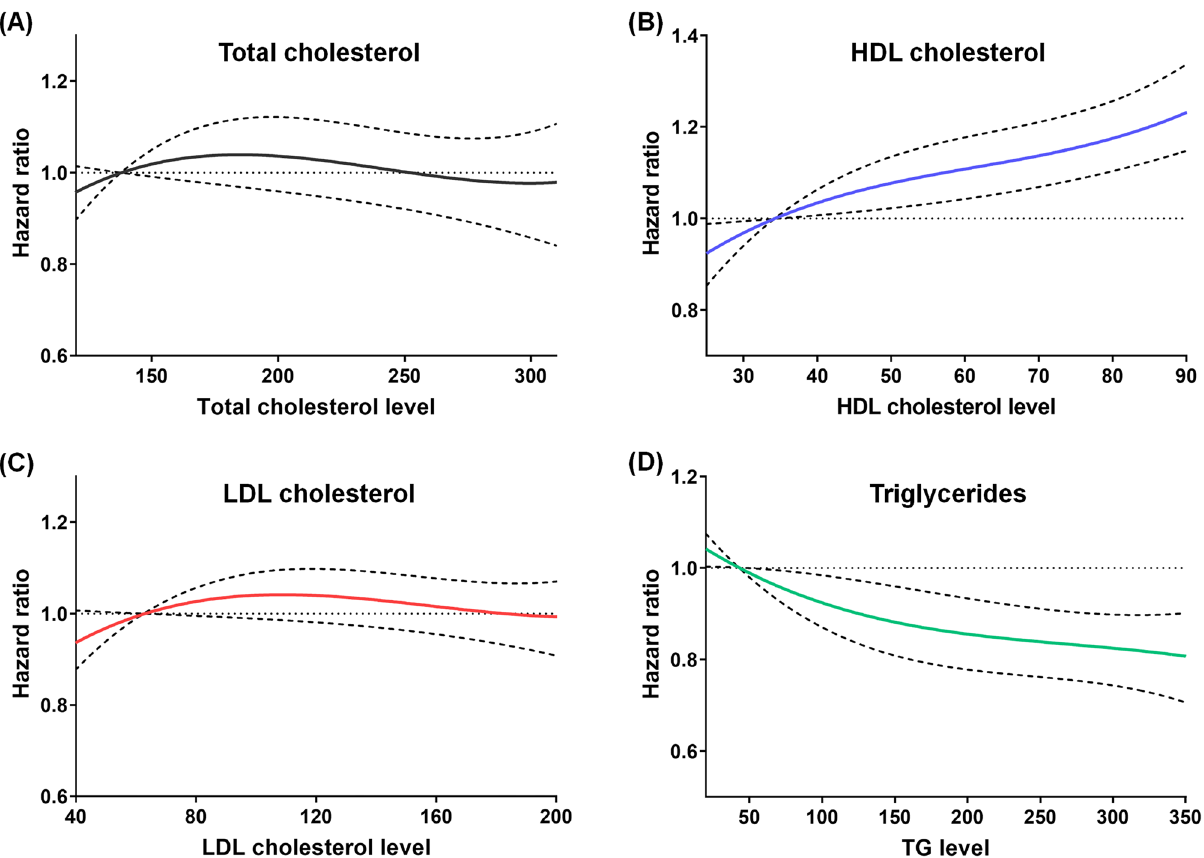
Figure 2. Restricted cubic spline curves presenting the adjusted hazard ratio for exudative age-related macular degeneration incidence according to total cholesterol, high-density lipoprotein cholesterol, low-density lipoprotein cholesterol, and triglyceride level. Curves represent HRs (solid lines) and their 95% CIs (dashed lines) based on restricted cubic splines for baseline total cholesterol ( A ), HDL cholesterol ( B ), LDL cholesterol ( C ), and triglyceride ( D ) levels with knots at the 5th, 35th, 65th, and 95th percentiles and the reference point at the 5th percentile of their distributions. The risk of exudative age-related macular degeneration continuously increased as HDL cholesterol levels increased ( B ) and triglyceride levels decreased ( D ) in the Cox proportional hazards model fully adjusted for demographic factors, systemic comorbidities, and behavioral factors (model